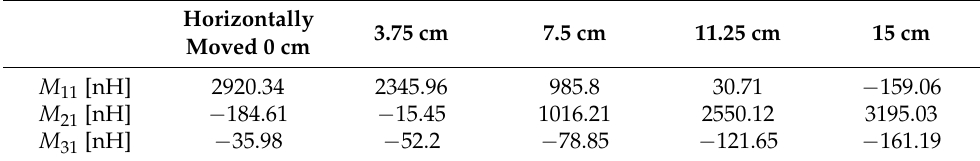
Table 2. Simulation Results of mutual inductance when there is only Rx 1 on charging space.